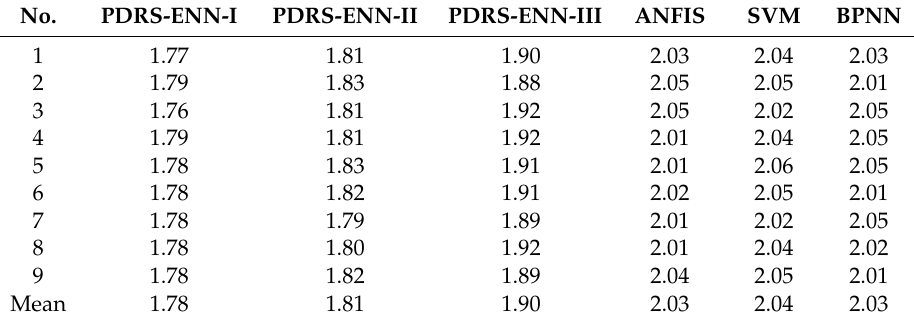
Table 12. The forecasting performance evaluated by FVD of